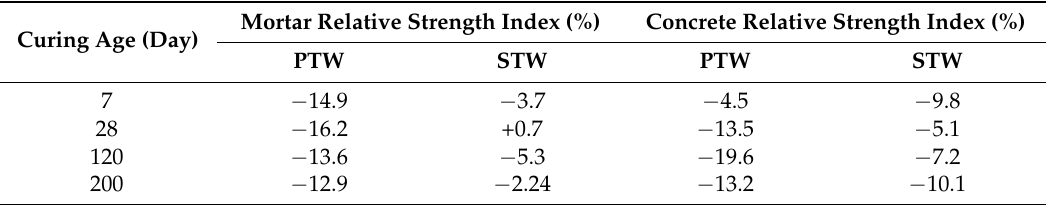
Table 6. Mortar and concrete relative strength index of mixes using PTW and STW.